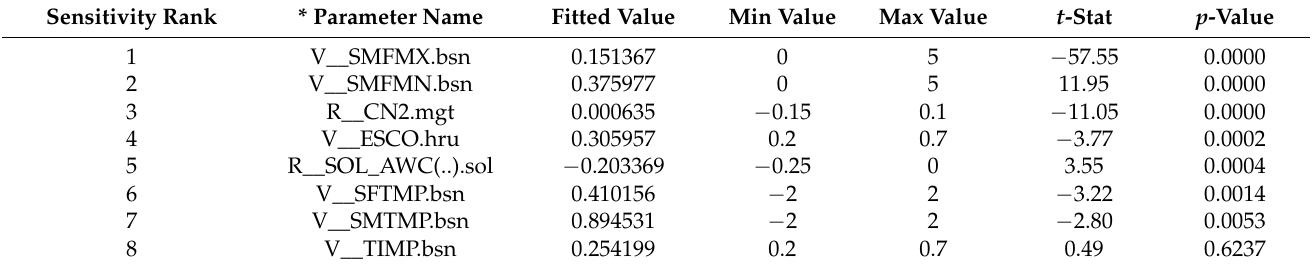
Table 2. List of the hydrologic parameters used in calibration and their respective value ranges and ranking.